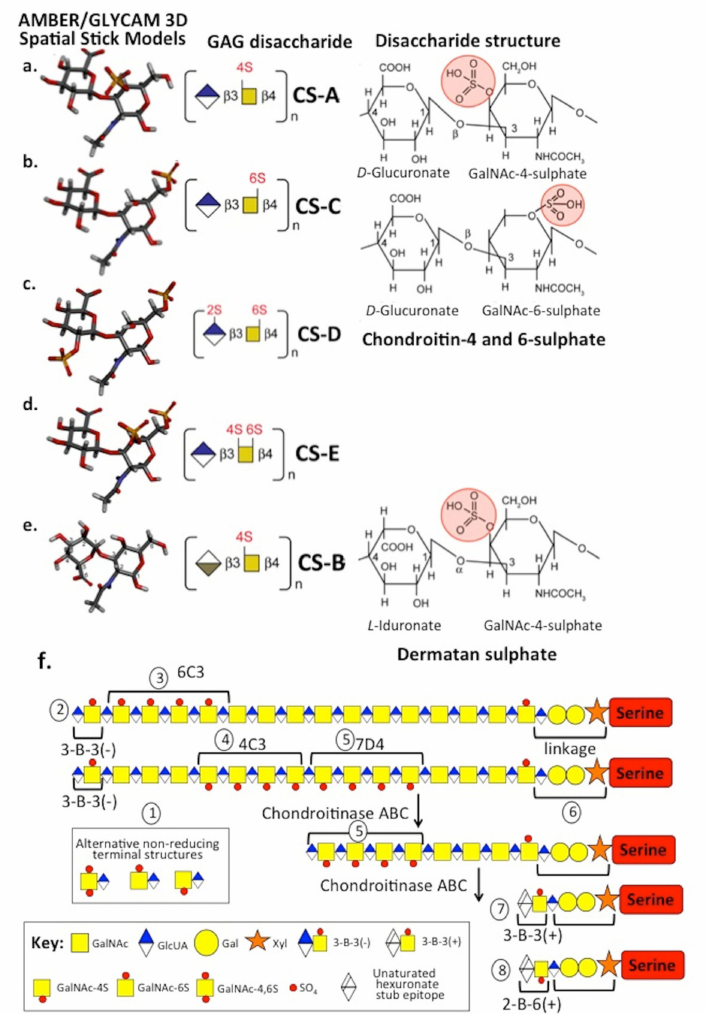
Figure 1. Amber / GLYCAM 3D stick structures of chondroitin sulphate isomers depicting their 3D conformations, disaccharide compositions and Haworth projection disaccharide structures showing sulphation positions ( a – e ). Schematic depiction of the structural organisation of the chondroitin sulphate glycosaminoglycan side chains of aggrecan depicting specific structural features of areas of the chain detected by monoclonal antibodies, putative sulphation patterns, linkage region structure to aggrecan core protein and non-reducing terminal structures ( f ). These regions on the CS side chain are numbered 1–8. Key: (1) Non-reducing terminal groups present on some cartilage aggrecan CS chains; (2) 3-B-3( − ) CS sulphation motif is also present as a non-reducing terminal component on some chains; (3) putative region on CS chain identified by MAb 6C3; (4) putative region on CS chain identified by MAb 4C3; (5) putative region on CS chain identified by MAb 7D4; (6) CS linkage attachment region to Serine residues of the aggrecan core protein; (7) 3-B-3( + ) CS sulphation stub epitope generated by exhaustive digestion of the CS chain by chondroitinase ABC and recognised by MAb 3-B-3; and (8) 2-B-6( + ) CS sulphation stub epitope generated by exhaustive digestion of the CS chain by chondroitinase ABC and recognised by MAb 2-B-6. Note: Regions 3–5 of the CS chains containing the 6-C-3, 4-C-3